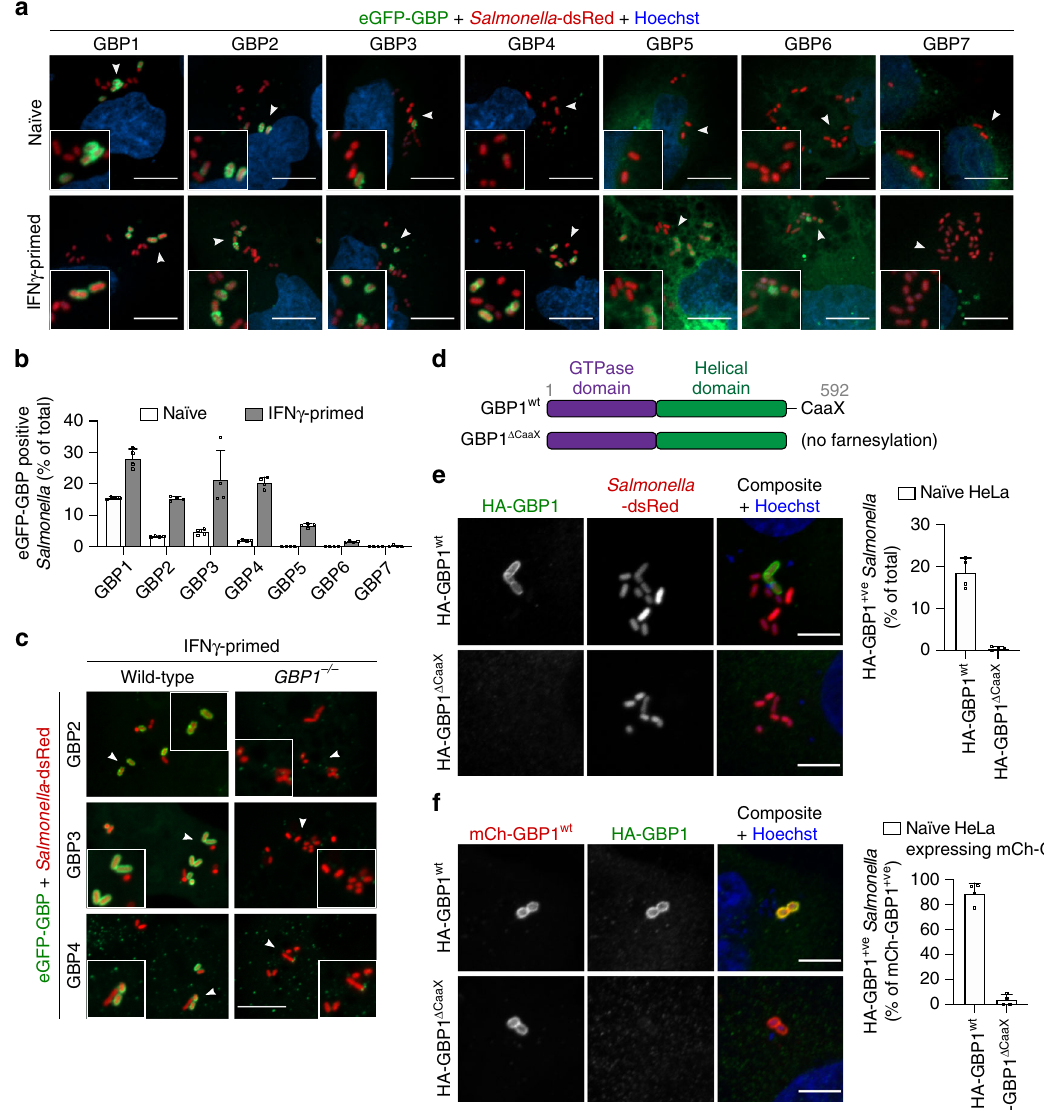
Fig. 3 GBP1 targets Salmonella and controls recruitment of GBP2-4. a Fluorescence confocal microscopy of naive or IFN γ -primed HeLa expressing N- terminal tagged eGFP-GBP1-7 (green) and infected with Salmonella -dsRed (red) for 1 h. DNA was stained with Hoechst (blue). Representative confocal images are shown and scale bars correspond to 10 µ m. b Percentage of intracellular Salmonella positive for eGFP-GBP1-7 in naive or IFN γ -primed HeLa, at 1 h p.i. At least 200 – 300 bacteria were counted per coverslip. c Fluorescence confocal microscopy of IFN γ -primed wild-type or GBP1 – / – HeLa expressing eGFP-GBP2-4 (green) and infected with Salmonella -dsRed (red) for 1 h. Representative confocal images are shown, and scale bar corresponds to 10 µ m. d Schematic representation of wild-type GBP1 and a Δ CaaX mutant. e , f Fluorescence confocal microscopy of naive GBP1 – / – HeLa expressing HA-GBP1 wt or HA-GBP1 Δ CaaX ( e ) or co-expressing mCherry-GBP1 wt and HA-GBP1 wt or HA-GBP1 Δ CaaX ( f ) and infected with Salmonella for 1 h. HA-tagged GBP1 was visualized by immunostaining with an anti-HA antibody. Representative confocal images are shown and scale bars correspond to 5 µ m. The percentage of HA-GBP1 positive bacteria was quanti fi ed by counting around 100 bacteria per coverslip. Graphs show the mean ± SD, and data are pooled from two ( b , e , f ) independent experiments performed in duplicate or representative of two ( a , c , e , f ) independent